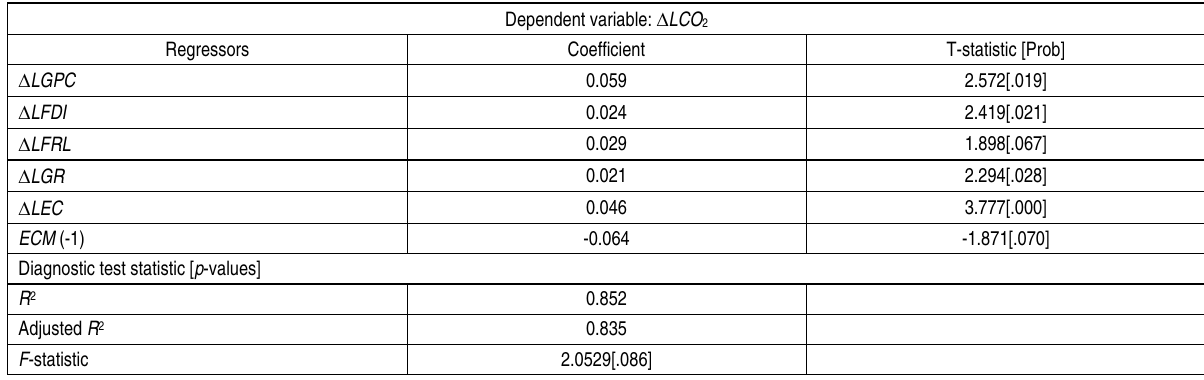
Table 5. Short-run estimates of the